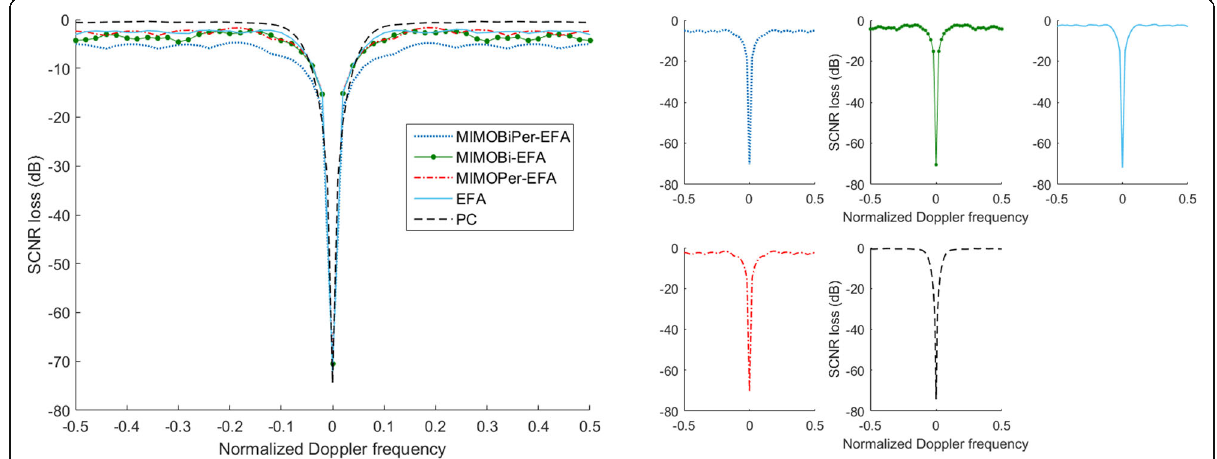
Fig. 5 SCNR loss curves with large training samples support ( L =